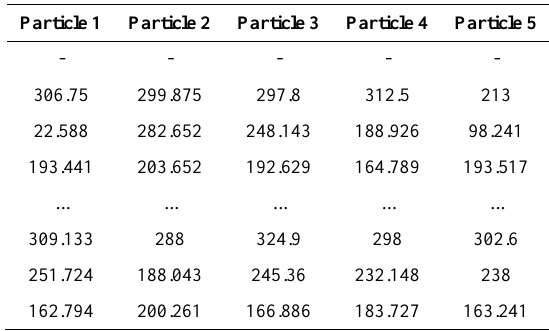
Table 22. Forecasting results for each